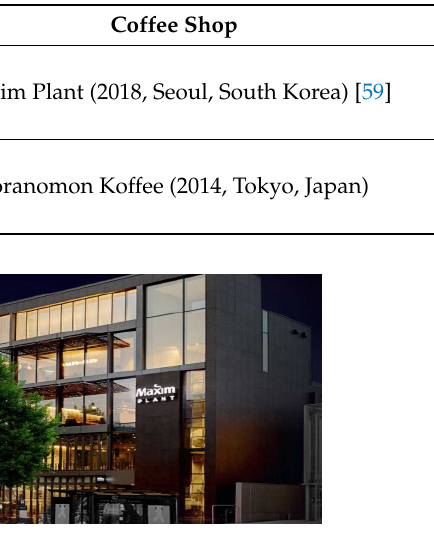
Figure 11. Maxim Plant (2018, Seoul, Korea).